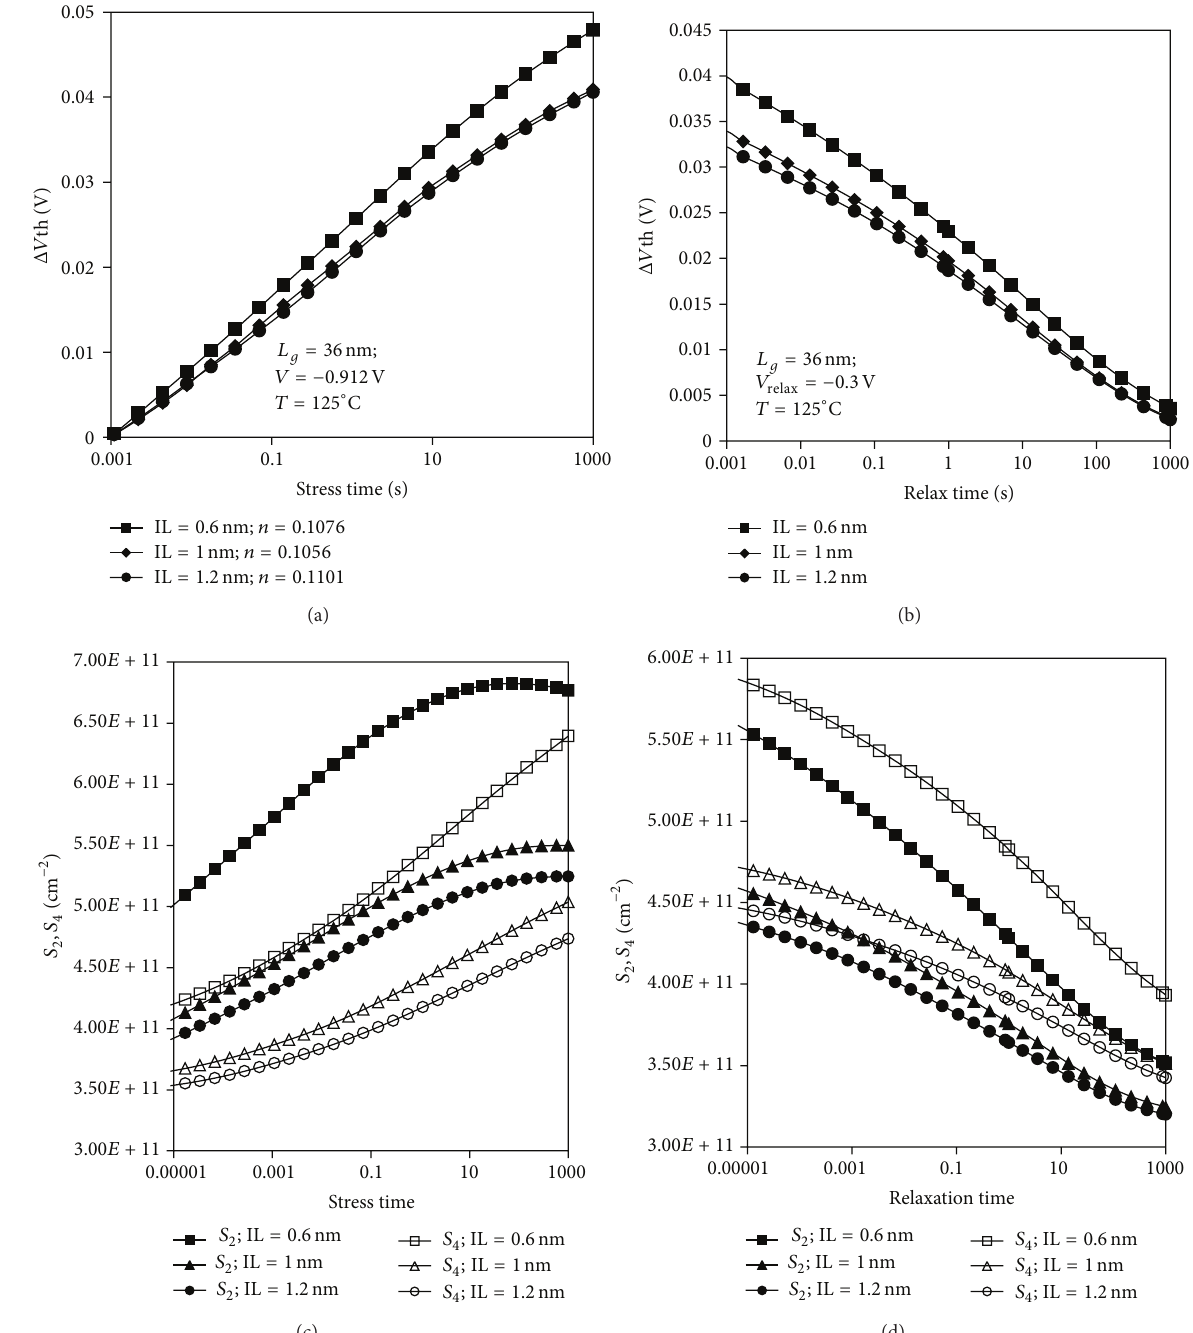
Figure 7: Threshold voltage shift for different SiO 2 IL thickness during the (a) stress phase and (b) relaxation phase as a function of stress and relaxation time, respectively. Time evolution of hole trap density, 𝑆 2 , and interface trap density, 𝑆 4 , for different SiO 2 IL thickness during the (c) stress phase and the (d) relaxation phase as a function of stress and relaxation time,